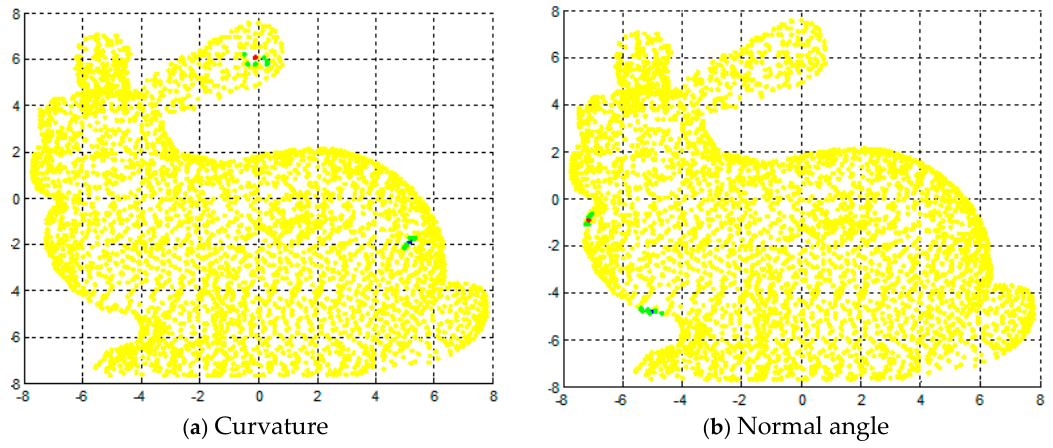
Figure 2. The detection results of feature points and non-feature points.